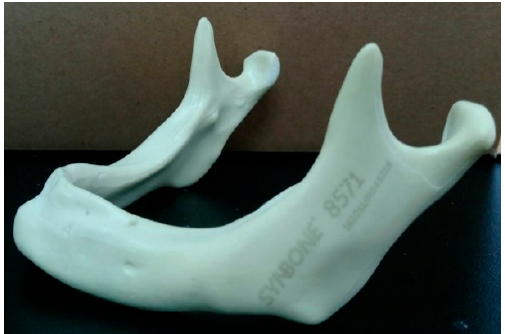
Figure 1. Synbone manufactured artificial edentulous mandibular bone model (model number: 8571).